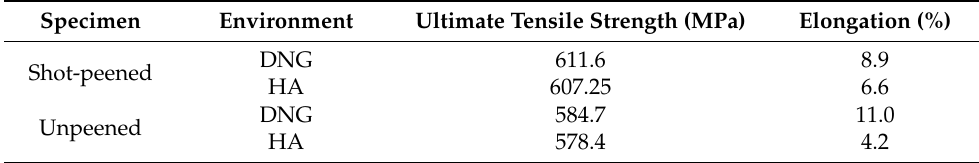
Figure 3. Representative tensile stress–strain curves of the specimens which were tested in humid air (HA) at strain rate of 10 − 5 min − 1 . Table 2. The results of SSRTs were conducted under various environments.